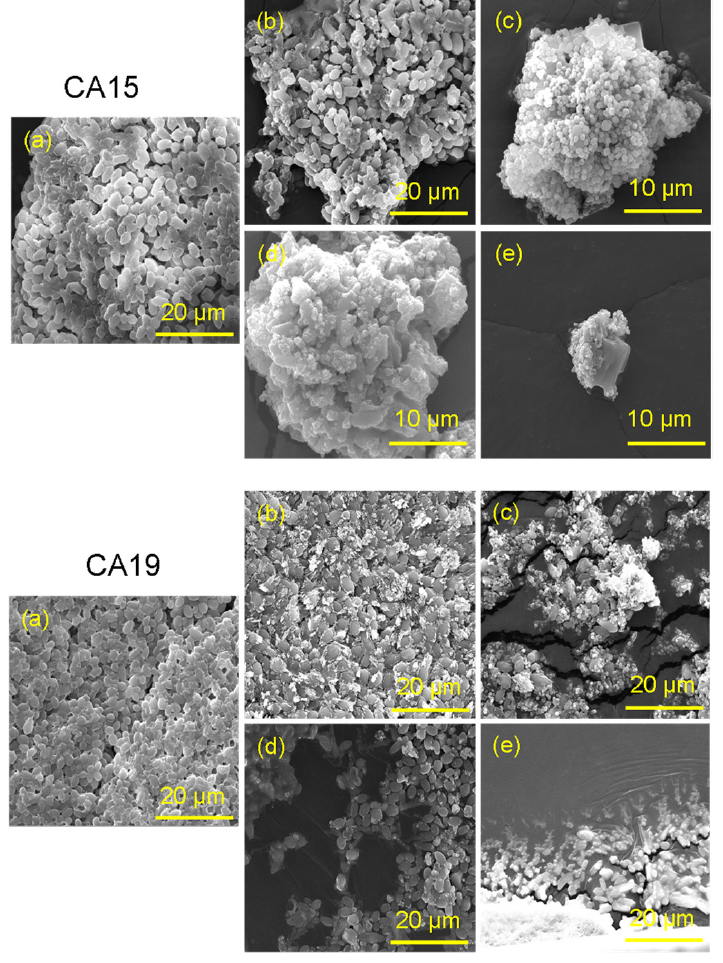
Figure 11. SEM micrographs showing the morphogenesis effect after treatment with nanomaterial. ( a ) Control (untreated); ( b ) Ti-ZSM-5; ( c ) Ag-silicalite-1; ( d ) 4 wt%Ag/TiZSM-5; ( e ) AgNO 3 .